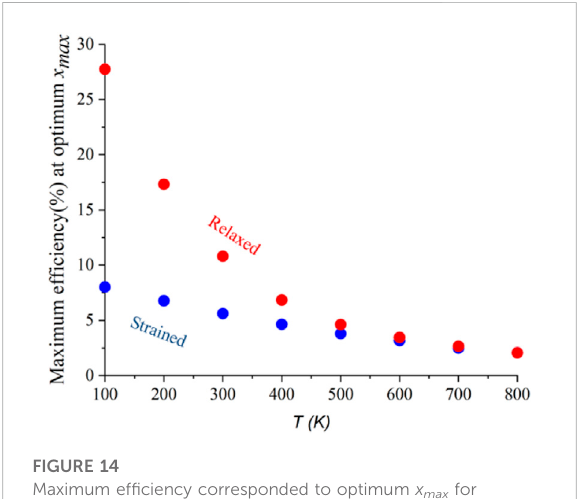
FIGURE 14 Maximum ef fi ciency corresponded to optimum x max for relaxed and strained